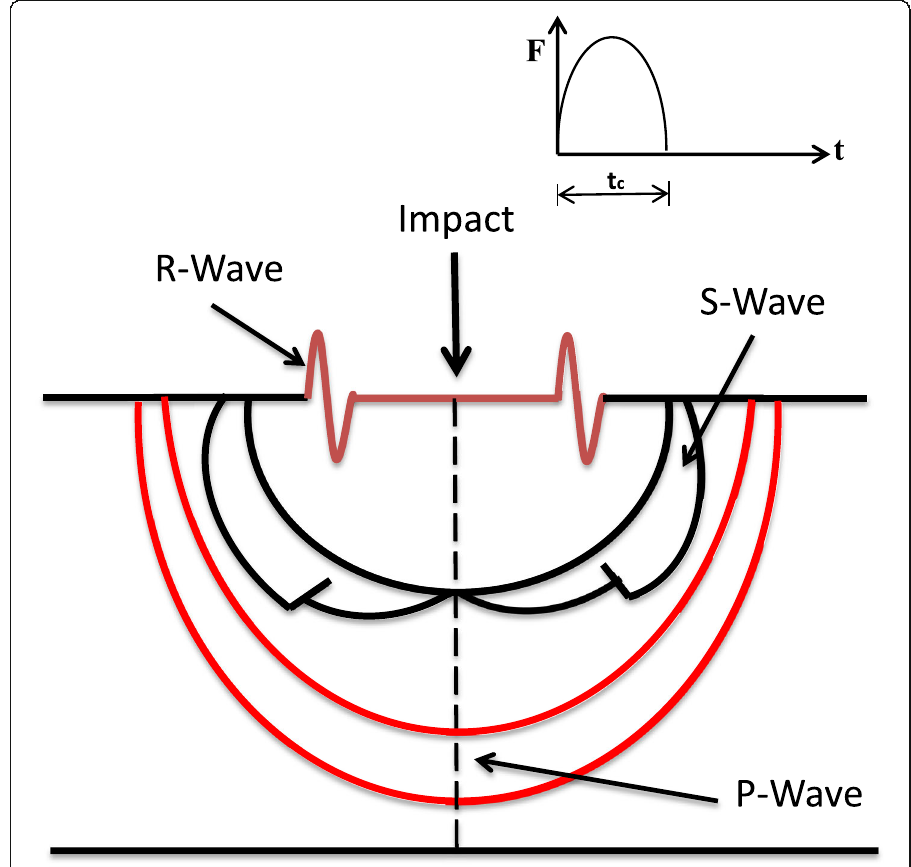
Fig. 2 Wave generation and propagation by impact